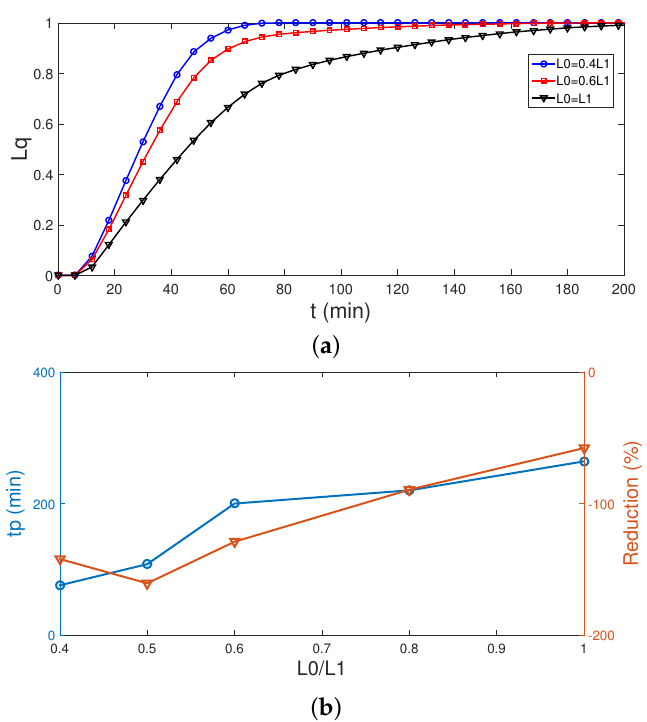
Figure 13. Effects of PCM-zone length on the time evolution of average Lq ( a ) and on the complete phase transition time (tp in minutes) ( b ) (Re = 300, Rew = 500, di = 0.25 L 1, yp = 0.1 H, and NC = 0.02).